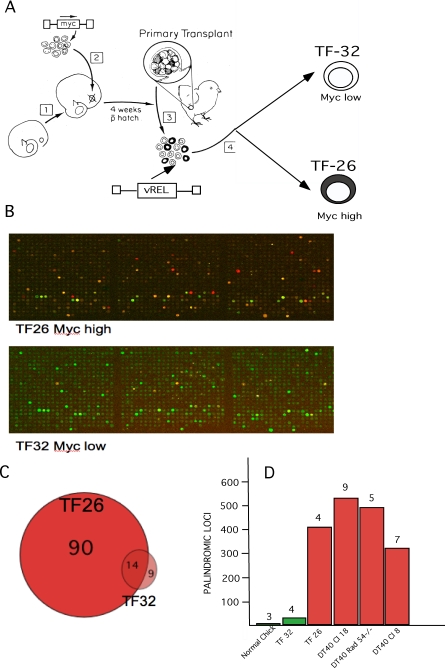
Analysis of transformed B-cells with high and low levels of Myc.(A) This chart shows the protocol for generating high and low Myc expressing bursal cell lines with vRel. Embryonic bursal cell populations were infected with a defective Myc oncogene-transducing retroviral vector LvMycSN [27] and used to reconstitute ablated bursal follicles in a bursal transplantation experiment [3],[4]. Reconstituted bursas contained mixtures of normal follicles and Myc over-expressing TF corresponding to successfully Myc-transduced bursal stem cells (depicted as black). Mixed normal and TF cell populations, from mixed normal follicles and TF, were then infected with Reticuloendotheliosis Virus, strain T, a vRel transducing retrovirus that rapidly transforms all chicken B-cells yielding clonal cell lines [26]. TF 32 is such a line of vRel transformed normal bursal cells and TF 26 a line of vRel transformed TF cells with a ∼50 fold increase in Myc expression [27]. (B) A section of the microarray from a ChIP on chip experiment with chromatin from high Myc TF 26 cells (upper panel) shows higher numbers of occupied Myc binding sites than observed on the same section of the array for low Myc TF 32 cells (lower panel). (C) The Venn diagram summarizes totals of occupied Myc binding sites in TF 26 and 32 cells. (D) This chart summarizes total numbers of palindromes consistently detected by GAPF in low Myc expressing normal bursal cells and TF 32 cells (green columns) in contrast with high Myc expressing (red columns) TF 26 cells and three different clones of DT40 bursal lymphoma cells, clone 8, clone18 parental and rad 54 -/- cells derived from clone 18. The numbers of individual GAPF microarray experiments used to derive totals of recurrently detected palindromes (>50% of experiments) are given above each column. Targeted deletion of Rad 54 from DT40 clone 18 was carried out and characterized by J-M Buerstedde and colleagues [28].